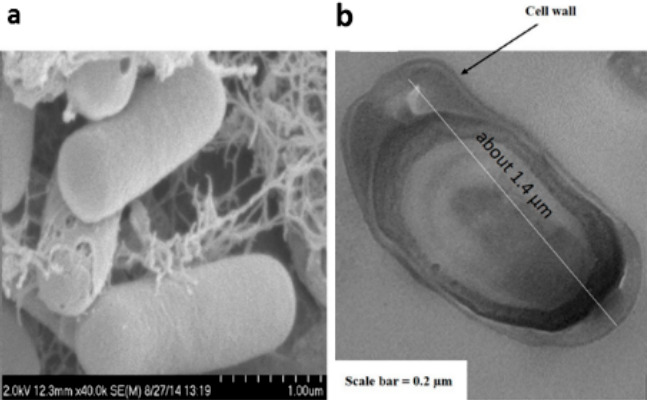
Figure 2. ( a ) Scanning electron micrograph of the Bacillus isolate. ( b ) Transmission electron micro- graph of positively screened Bacillus isolate .